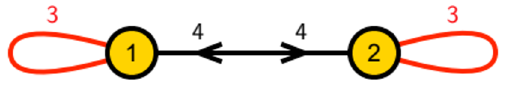
Figure 7 . Quiver for C 4 / Z 2 (1 , 1 , 1 , 1) . The numbers next to edges correspond to the multiplicity of field between the adjacent nodes in the quiver